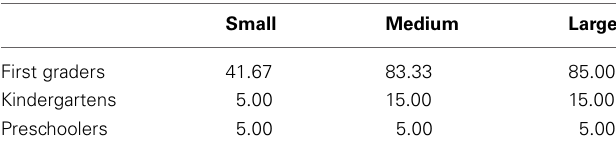
as a function of school level and numerosities.